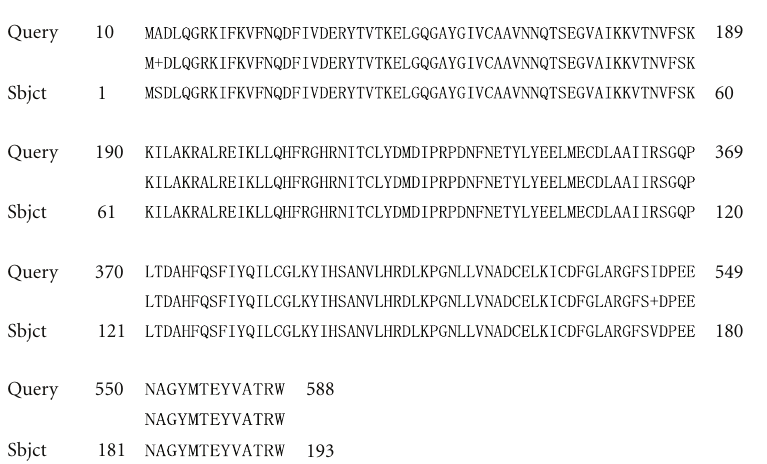
gb | AAC63682.1 | MAP kinase Mps1 [ Magnaporthe grisea ] Length = 415 Score = 394 bits (1013), expect =